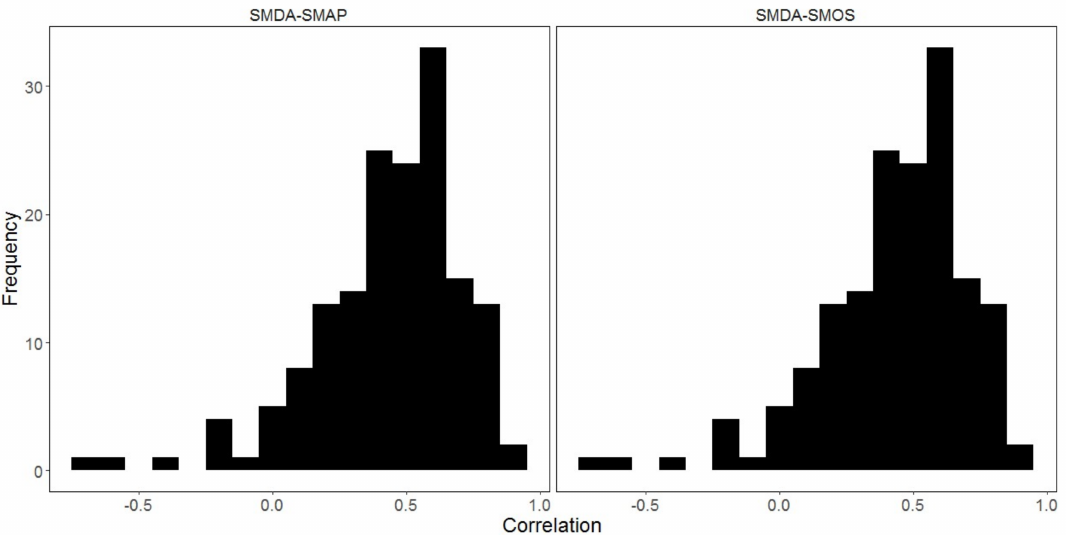
Figure 8. Comparison of PDSI modelled from station data to SMDA from blended SMAP-SMOS time series and SMOS only time series ( top ). Trend line represents a linear correlation of 0.28 for the SMAP-SMOS SMDA and 0.36 for the SMOS-only SMDA, significant at p < 0.001. Histograms ( bottom ) show distribution of correlation coefficients for data from each of the 346 climate